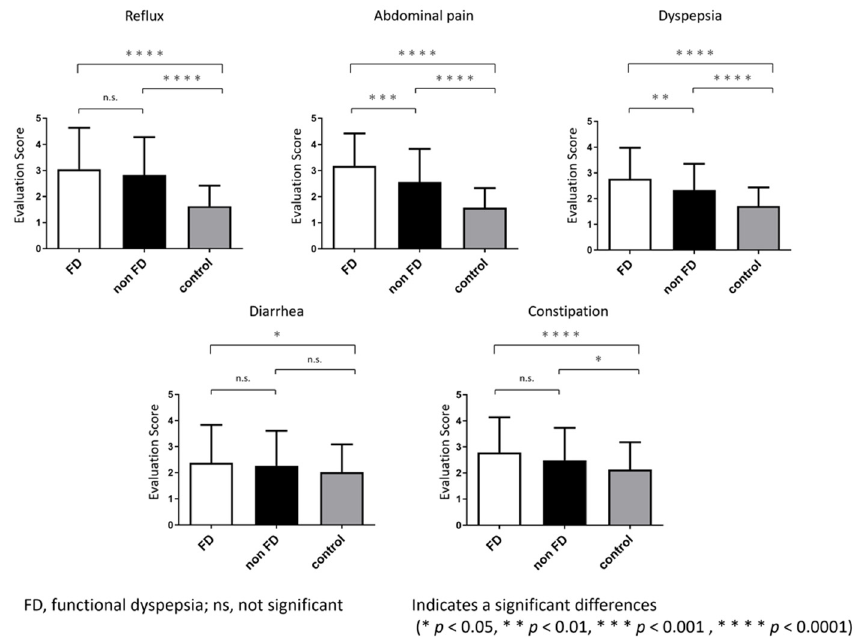
Figure A1. GSRS score of FD and non-FD patients.